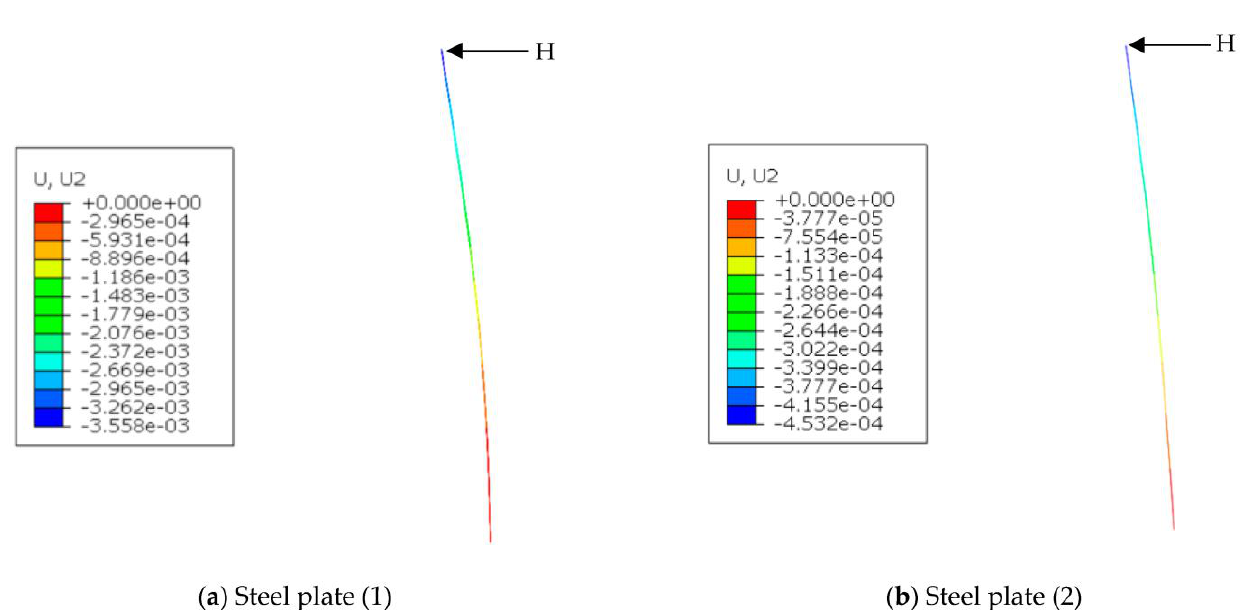
Figure 9. Simplified numerical model SM1, with evidence of the local analysis of lateral deflections measured in steel plates (1) and (2). Comparative calculations for the assessment of simplified empirical formulations in use for sub-scheme SS1 (ABAQUS). Legend values in m (out-of-scale deformed shapes).